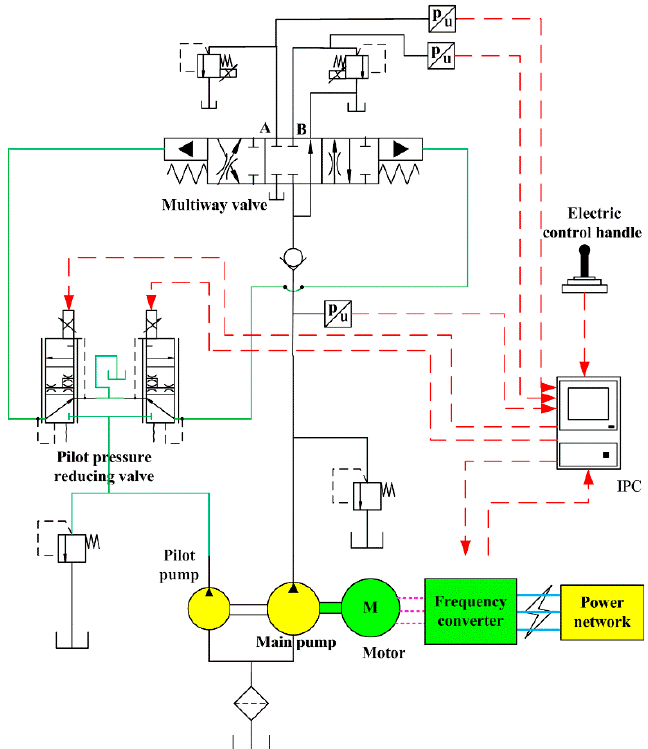
Figure 1. Principle diagram of the positive flow system (PFS) of an electric excavator based on variable speed control.